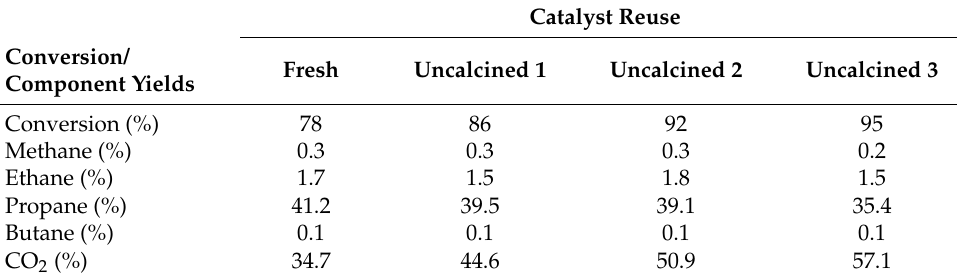
Table 7. Effect of catalyst reuse on butyric acid conversion and gas yields.